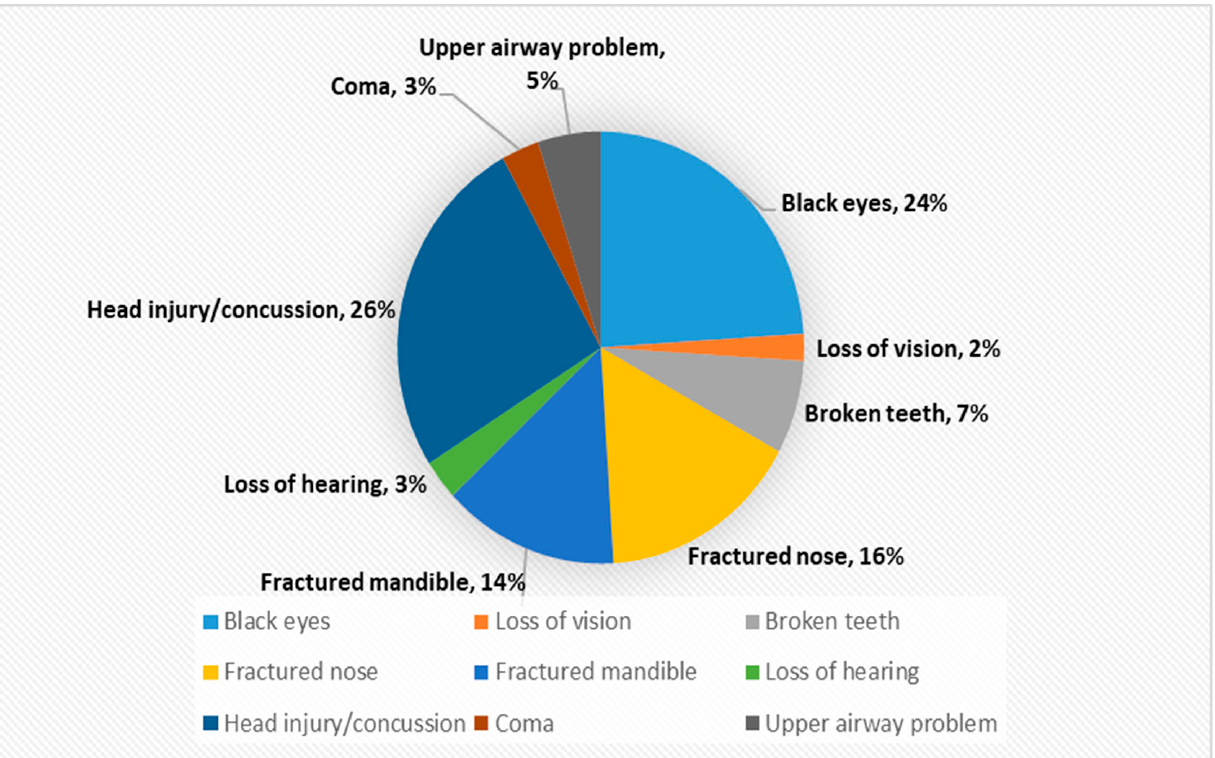
Figure 2. Composition of head and neck injuries as a % ( n = 58).